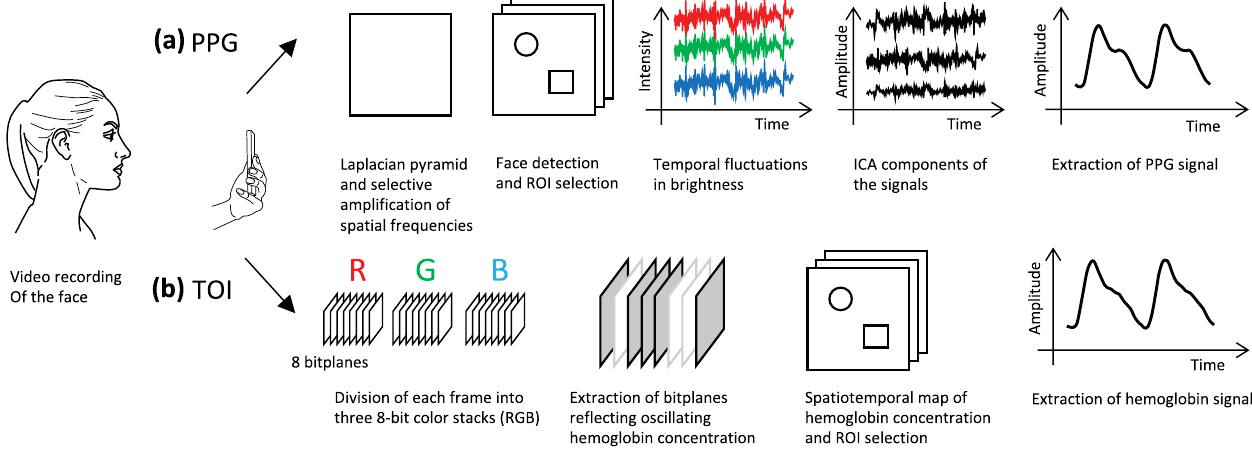
Fig. 3 Construction of the PPG (a) and TOI (b) signals from a facial video. To obtain the PPG signal from the regions of interest, the frames are fi rst processed to reduce noise and amplify the relevant information. Then, three signals are created per region of interest (ROI) by spatially averaging the pixel brightness of red, green, and blue over the entire ROI in each frame. In a last step, independent component analysis (ICA) is applied and the signal is band-pass fi ltered and smoothed to obtain the PPG signal. In the case of transdermal optical imaging (TOI), the information in each frame is divided into three color channels that are each comprised of an 8-bit color stack. Each bit of the stack constitutes a bitplane. Subsequently, bitplanes of the stack with characteristic fl uctuations in one's are isolated using a machine learning model. With this data, a spatiotemporal map of hemoglobin concentration is created, regions of interest are identi fi ed and the hemoglobin concentration is spatially averaged in each frame to obtain a hemoglobin signal for each region of